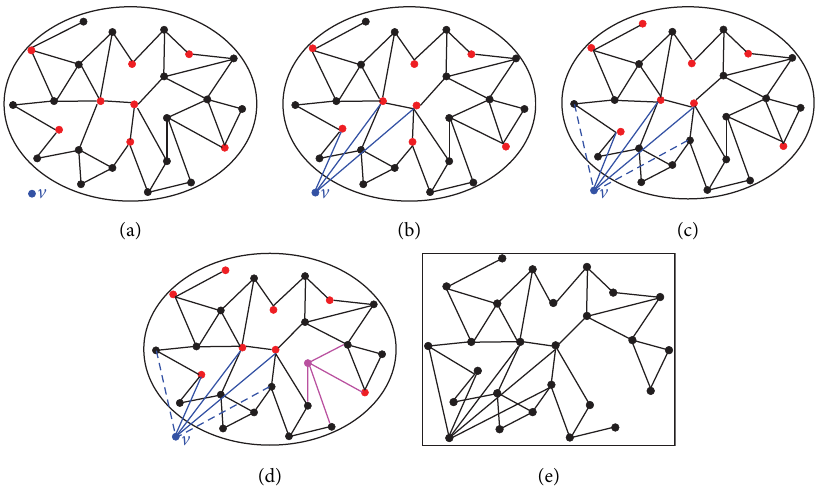
Figure 1: Sketch of the network evolving process with the local-world size M � 8 and the value m � 3. In (a), M nodes (the red nodes) are randomly selected as the local world of the new node v (the blue node). In (b), m nodes in the local world are chosen to be connected with v by blue lines according to the preferential attachment. In (c), for the m nodes in (b), a randomly chosen neighbor is linked to v (by blue dashed line) with probability p . In (d), one randomly selected node as well as its links (denoted by pink color) is deleted from the network. Ten, the network after one step, i.e., adding one node and then deleting one node, is shown in